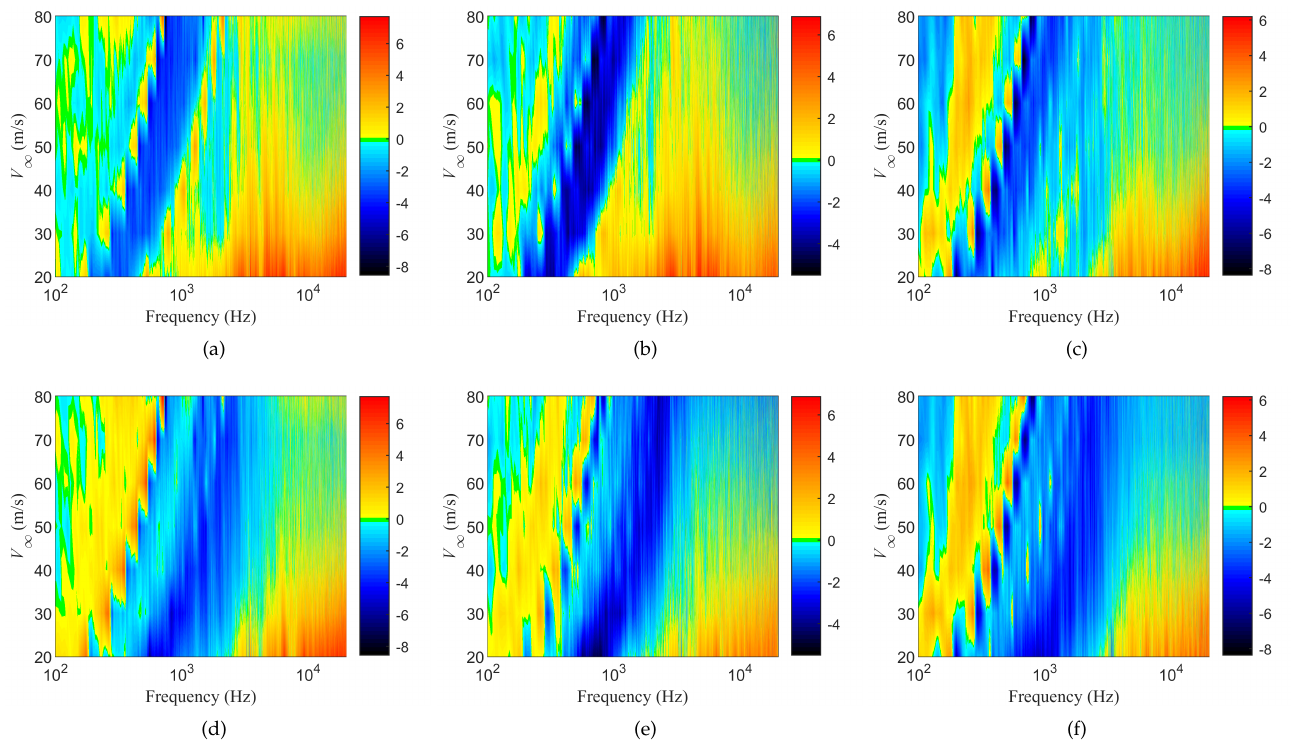
Figure 14. ∆ SPL as a function of frequency and flow velocity for different arrangements of the porous leading edges: ( a ) X120Y80Z40, L = 100 mm, α = 0 ◦ ; ( b ) X120Y80Z40, L = 200 mm, α = 0 ◦ ; ( c ) X120Y80Z40, L = 200 mm, α = 10 ◦ ; ( d ) X40Y80Z120, L = 100 mm, α = 0 ◦ ; ( e ) X40Y80Z120, L = 200 mm, α = 0 ◦ ; and ( f ) X40Y80Z120, L = 200 mm, α = 10 ◦ .